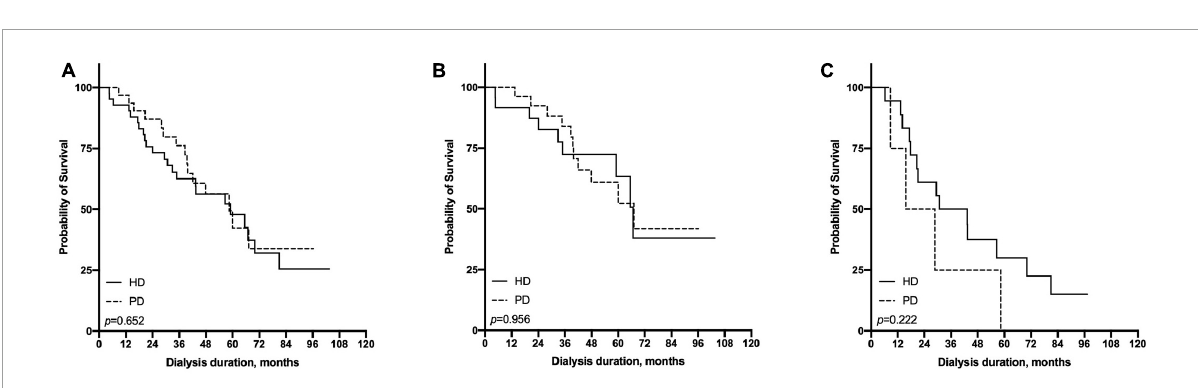
FIGURE6 Comparison of survival rate between HD and PD in the subgroup of patients with reduce LVEF ( ≤ 55%) [ (A) all patients, (B) ≤ 65 years old group, (C) > 65 years old